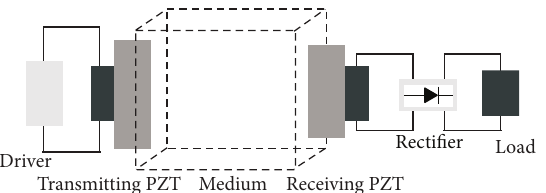
Figure 1: Fundamental schematic of AET